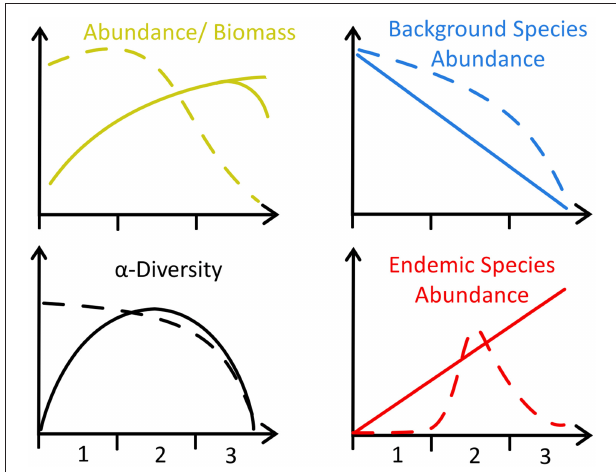
FIGURE 5 | Schematic of four faunal trends in diffuse hydrothermal vents, adapted from Bernardino et al. (2012) (solid lines) to include Southern Ocean data (dashed lines). Axes labels refer to three distinct regions of the Bransfield Strait identified by this study with reference to previous work (Sahling et al., 2005; Aquilina et al., 2013): 1 = No hydrothermal activity (i.e., Control, Three Sisters and the Axe), 2 = Moderate hydrothermal activity (i.e., Hook Ridge 1, optimal S. contortum habitat), and 3 = Higher hydrothermal activity, unsuitable for most fauna.